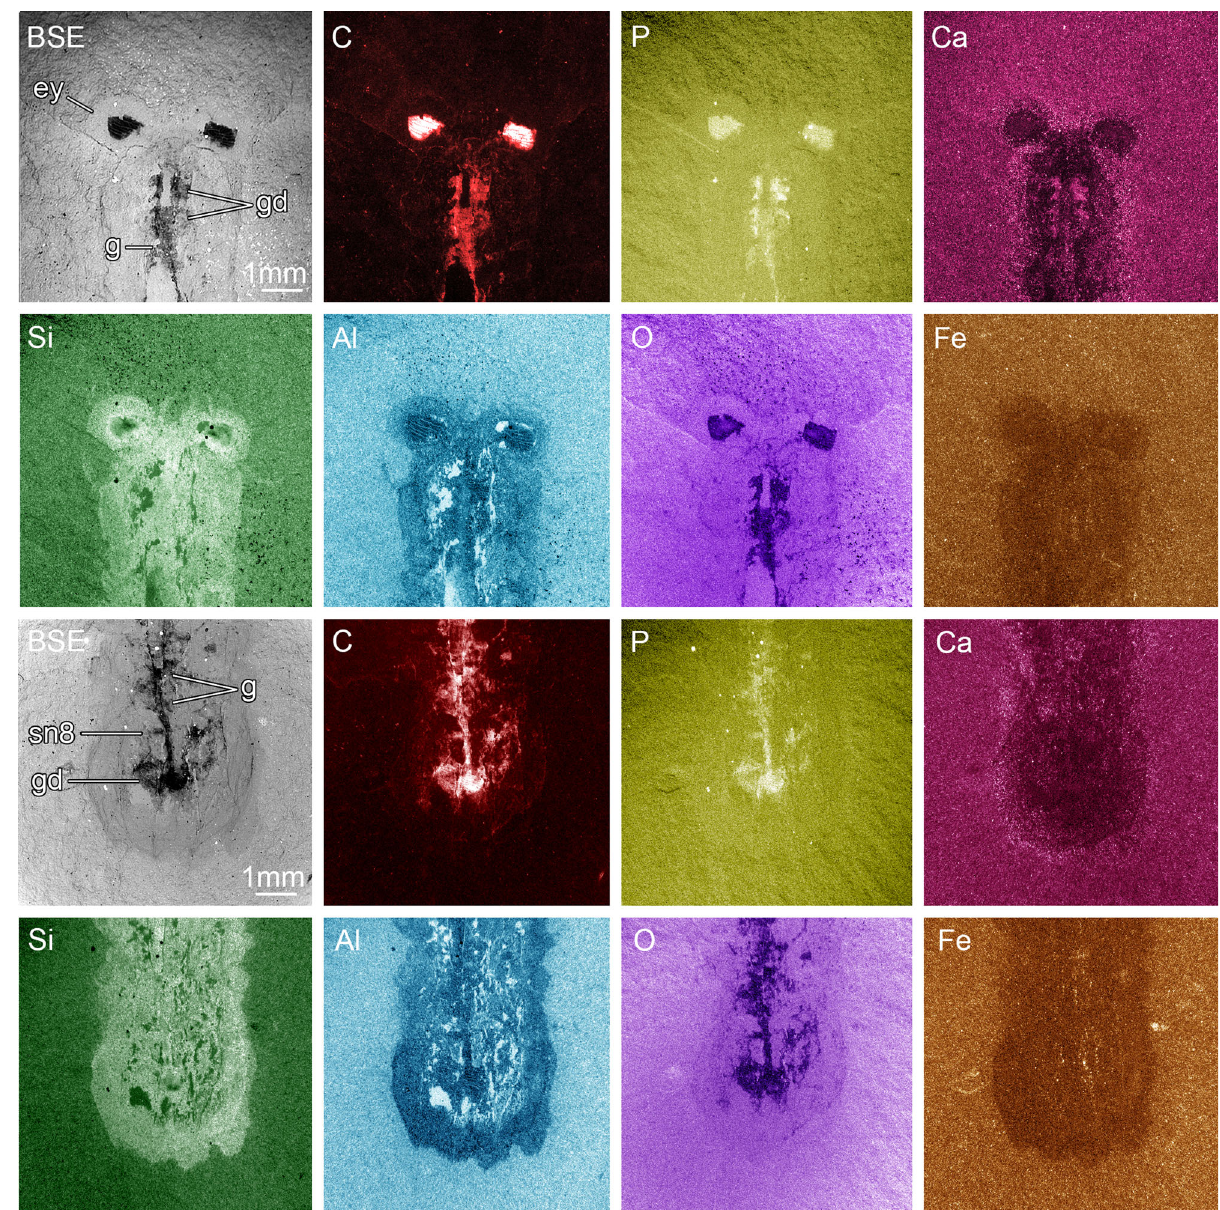
Fig. 2 Elemental maps of MCZ 1811 head and posterior regions. The specimen demonstrates preferential enrichment of carbon (C) and phosphorous (P) associated with labile soft tissues including the pigmented retina, optic nerves, gut tract, and paired diverticula. Furthermore, the presence of calcium (Ca) in the gut tract and diverticula indicates early diagenetic replacement by calcium phosphate. ey lateral eye, g gut tract, gd gut diverticulum, sn8 segmental nerve